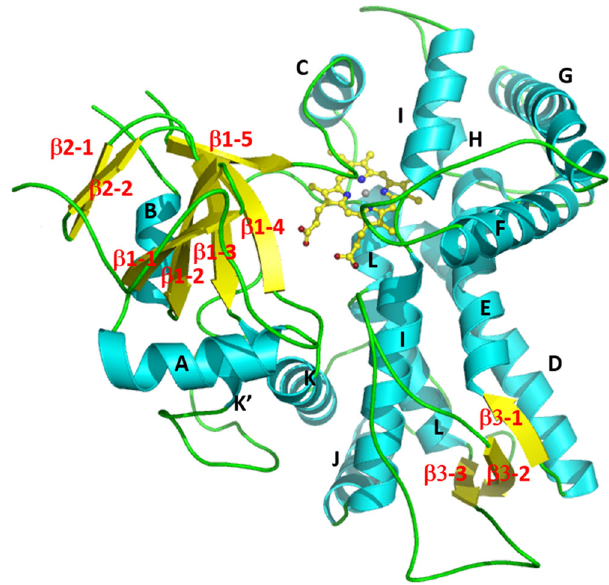
Fig. 2 Ribbon diagram of the M. truncatula 2-HIS structure. The α helices, β strands and the N- and C-termini are labeled. Fig. 1 – 6 were prepared with MOLSCRIPT 51 and RASTER3D 52 , or PyMOL 53